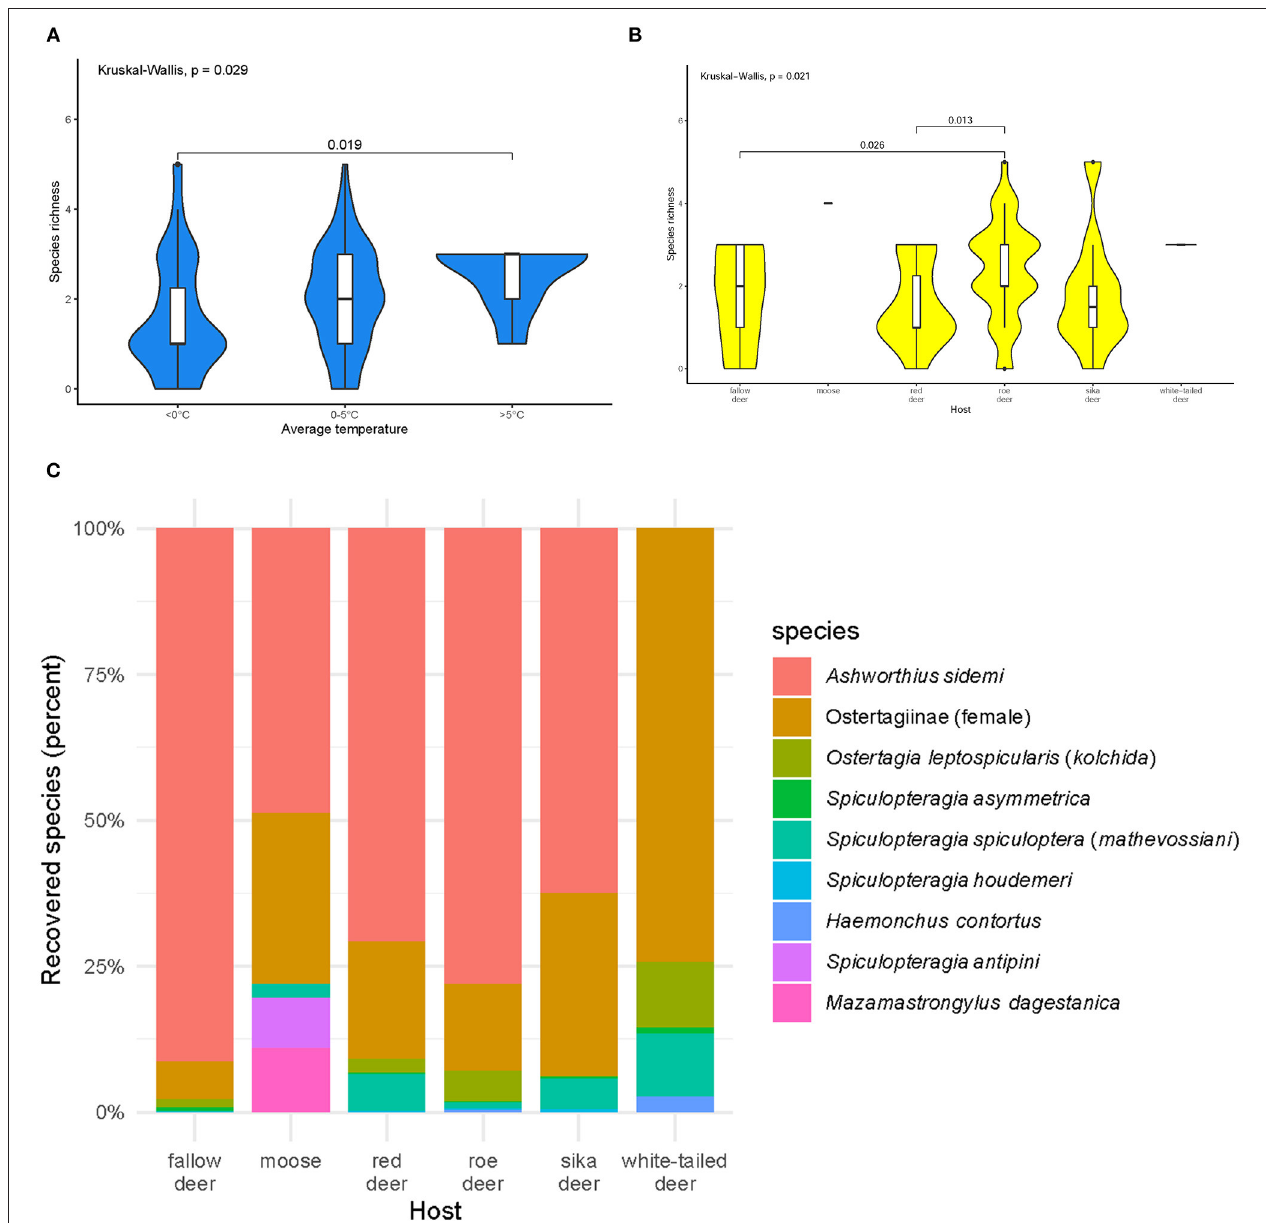
FIGURE 2 | Species richness of abomasal nematodes (A) in periods with different average temperatures (B) in examined host species, and (C) community structure of abomasal nematodes identified in the cervid hosts during necropsies: fallow deer ( n = 31), moose ( n = 1), red deer ( n = 20), roe deer ( n = 40), sika deer ( n = 10), and white-tailed deer ( n = 2). Females from the subfamily Ostertagiinae were merged into one group. Black dots symbolize outliers. Host species are sorted alphabetically.